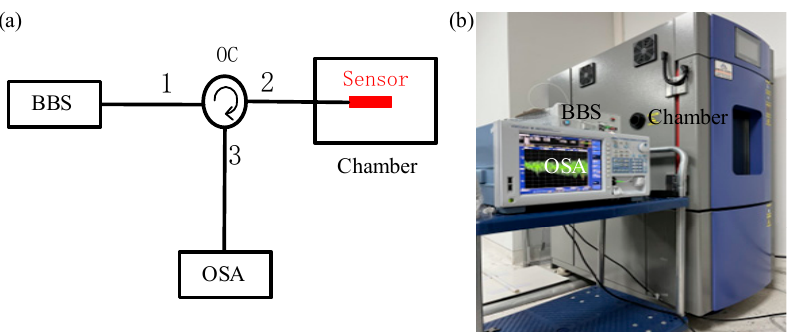
Figure 8. Experimental setup for the RH measurement. ( a ) Structural schematic diagram and ( b ) actual experimental installation.